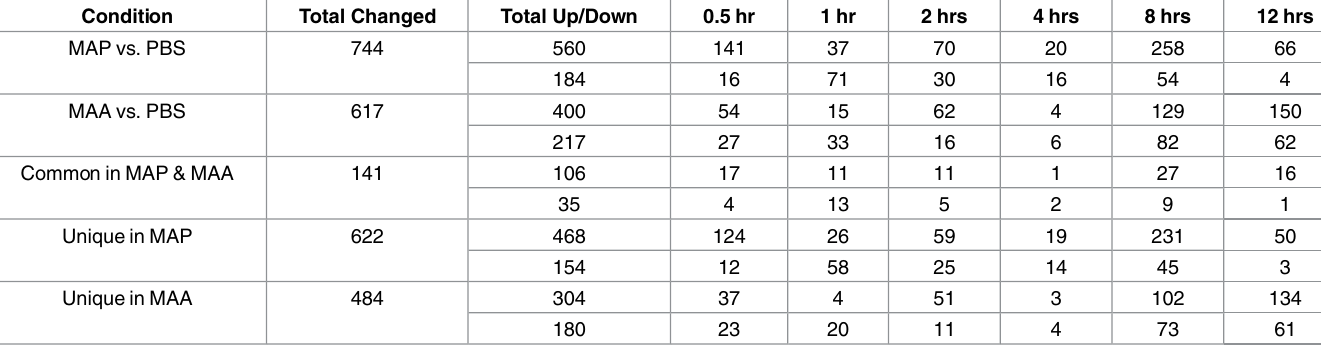
Table 1. Analysisof numberof expressed geneschangedduringthe MAP and MAA infection. Condition Total Changed MAP vs. PBS MAA vs. PBS Common in MAP & MAA Unique in MAP Unique in